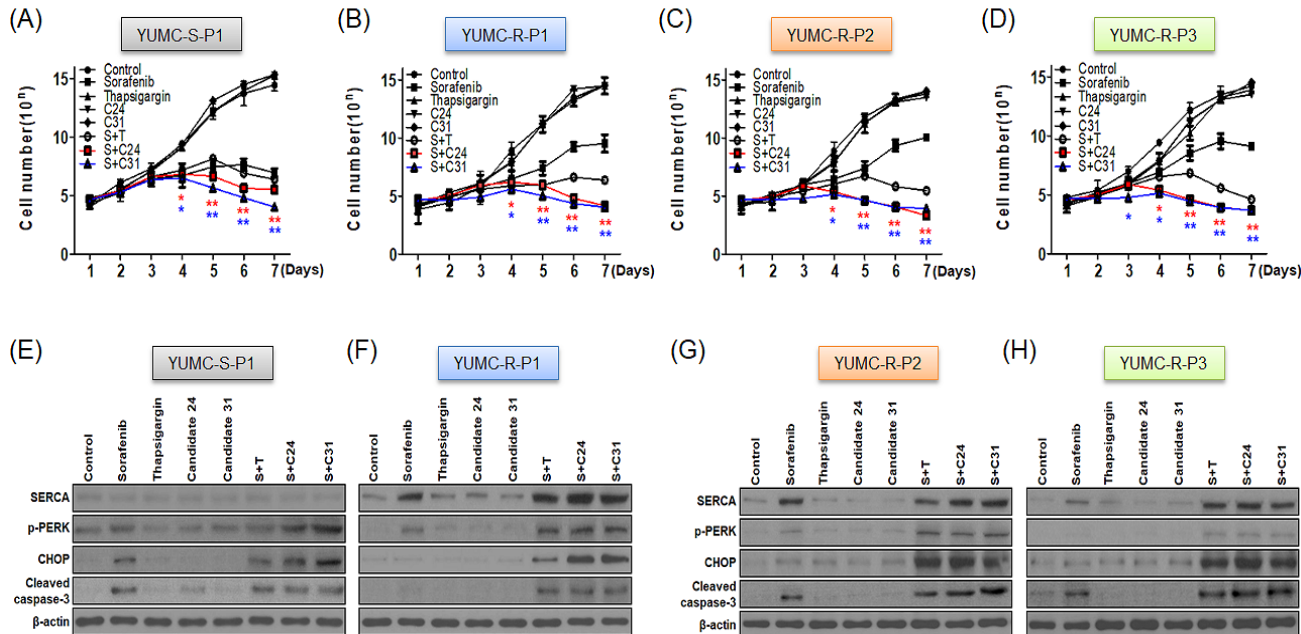
Figure 3. Inhibition of cell proliferation and apoptosis level estimated using cell proliferation and immunoblot analysis. Cell proliferation ( A – D ) and immunoblot analysis ( E – H ) of human sorafenib-sensitive ( A , E ), YUMC-S-P1) and -resistant (( B , F ), YUMC-R-P1; ( C , G ), YUMC-R-P2; ( D , H ), YUMC-R-P3) PTC cells. ( A – D ) Human PTC cells were presented with sorafenib and SERCA inhibitors, either combined or alone. ( E – H ) Immunoblot analysis with SERCA, p-PERK, and CHOP (endoplasmic reticulum stress marker), and cleaved-caspase-3 (apoptosis-related marker) in sorafenib-sensitive (YUMC-S-P1) and -resistant (YUMC-R-P1, -P2, and -P3) PTC cells. * p < 0.05 and ** p < 0.01 versus control. *; C24 and *; C31.